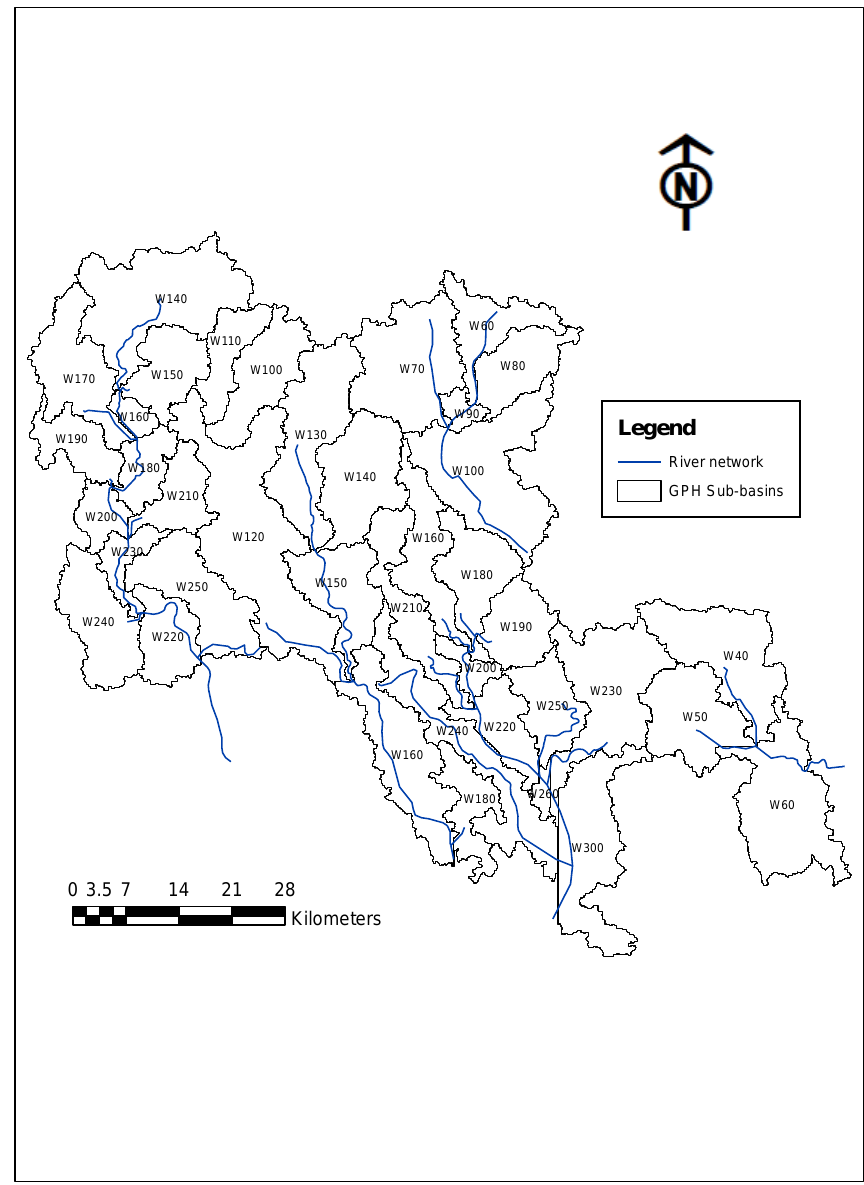
Figure 2. Map of the Greater Port-Harcourt watershed showing the sub-basins of the studied watershed.